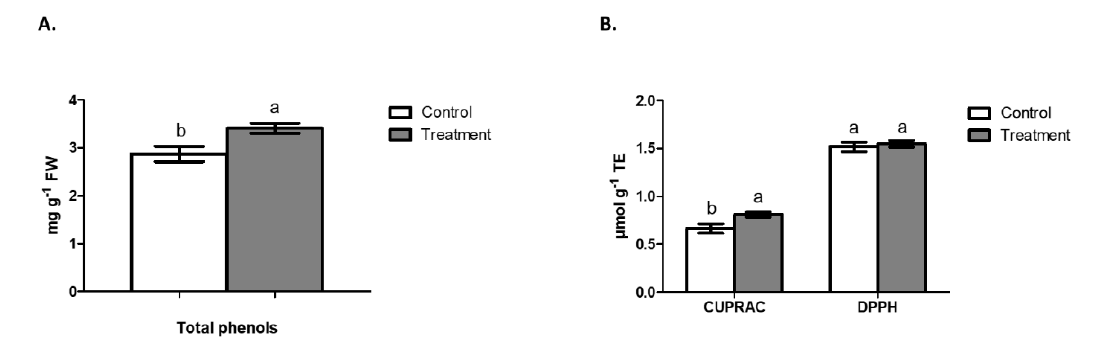
Figure 4. Total phenols and antioxidant activity in phenolic extract of Imperata cylindrica shoots. ( A ) Total phenols by Folin Ciocalteau, after 21 days of Cu exposure. ( B ) Antioxidant activity determination by DPPH and CUPRAC after 21 days of Cu exposure. Control condition (without Cu applied) and treatment (300 mg Cu kg −1 substrate). Different lowercase letters indicate statistic difference according Tukey’s multiple range test ( p < 0.05). Data are expressed as mean ± SE, n = 4.